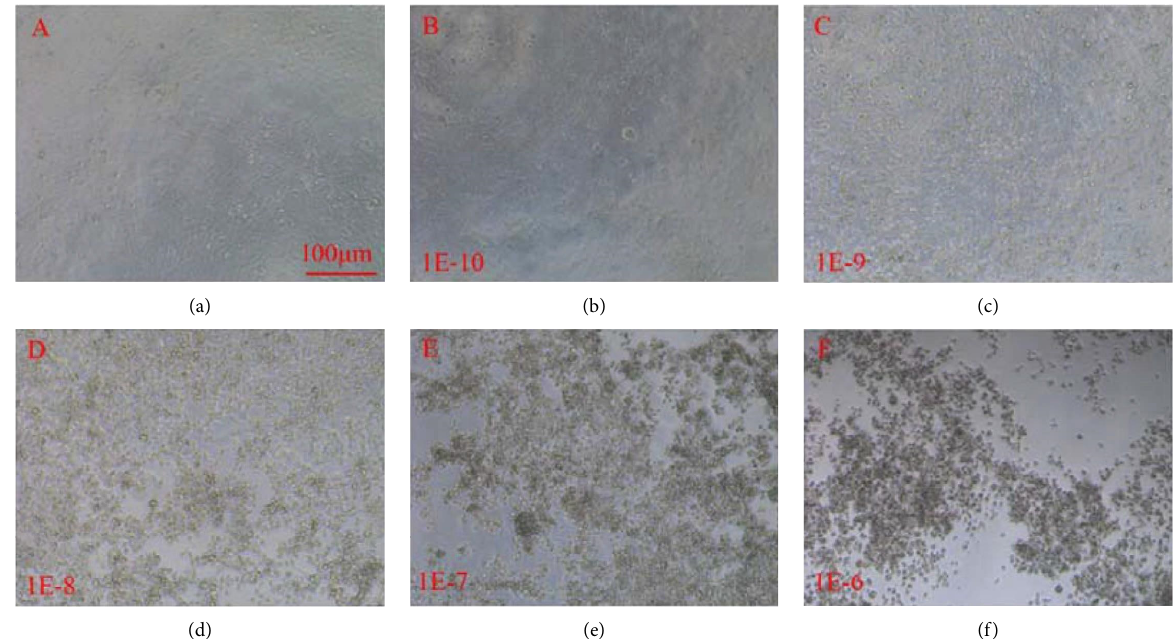
Figure 2: Morphological changes in HEK293 cells observed using the bright microscope. It showed that the morphology of the infected HEK293 was determined by the titers of Ad-Ndufs4 siRNA. Te cells in the control group was normal, and the higher the virus titer, the greater frequency of CPE